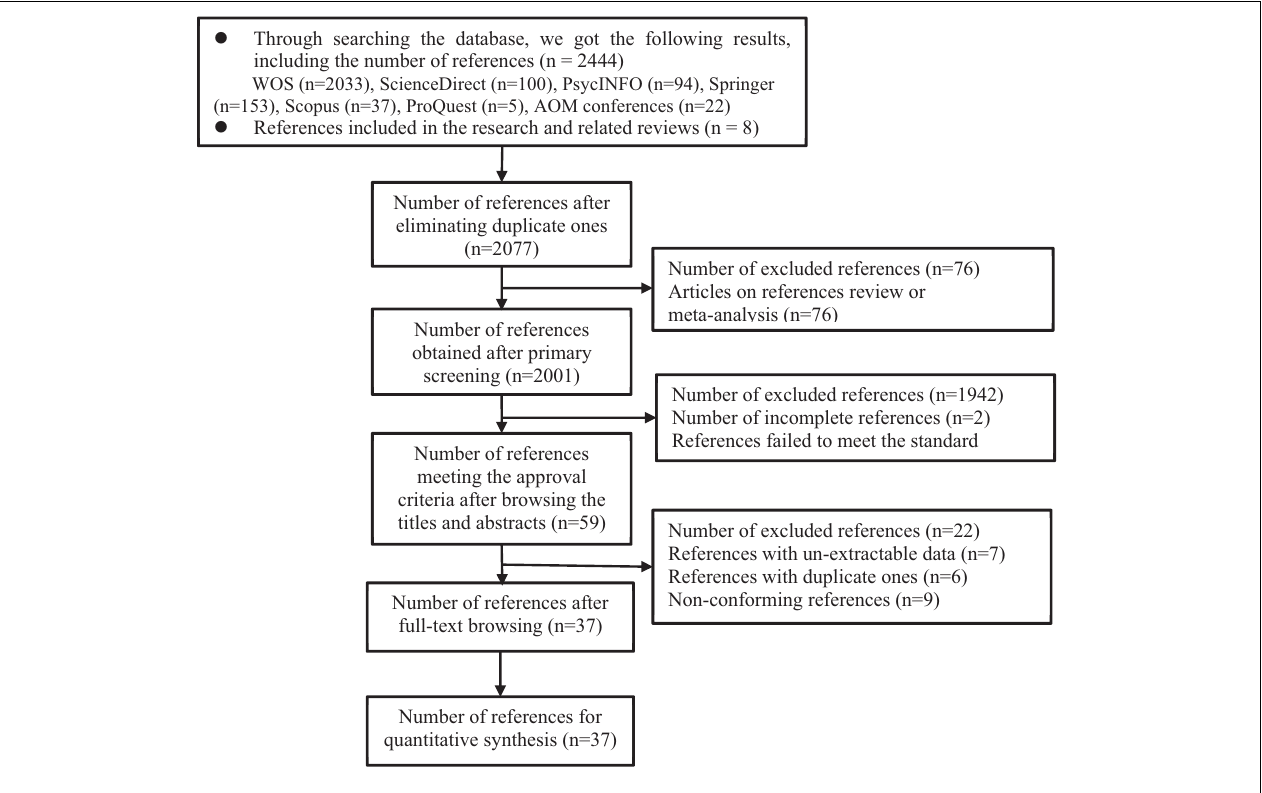
FIGURE 1 | Flow chart of the searching and screening of